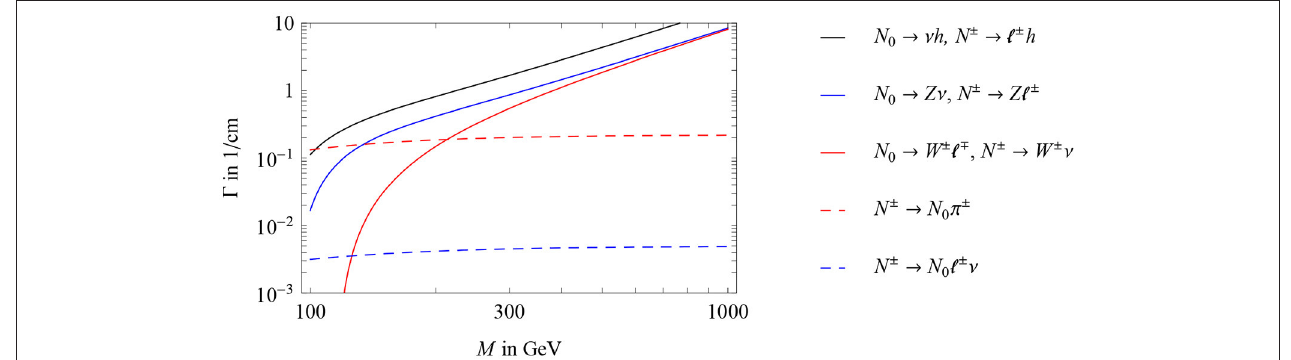
FIGURE 34 | Triplet decay widths as function of the triplet mass and assuming M h